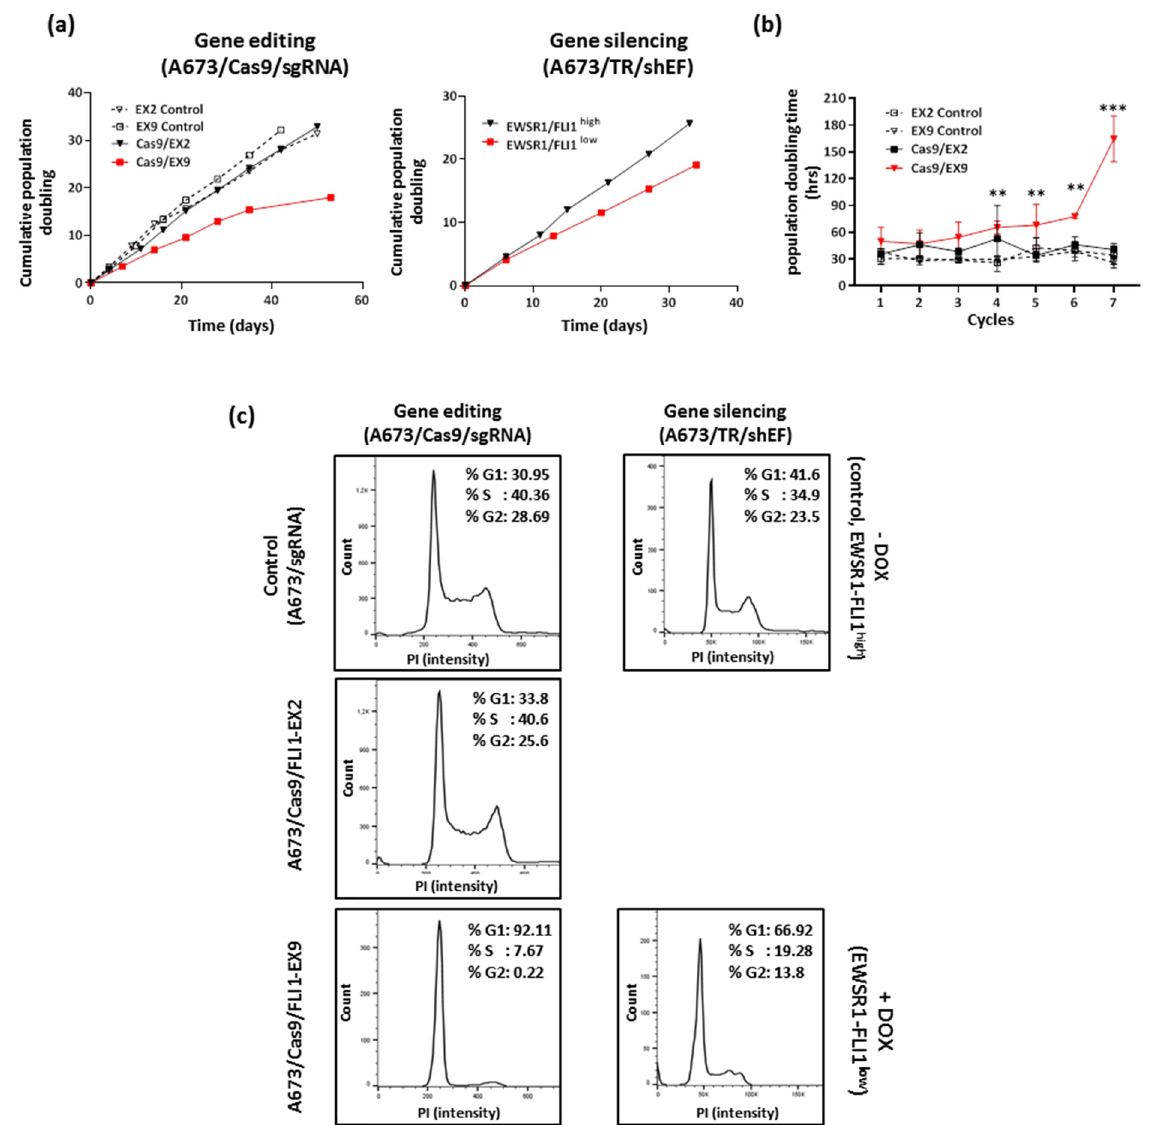
Figure 3. Effect of EWSR1–FLI1 gene editing on cell proliferation. ( a ) A673/Cas9/sgRNA cells were continuously main- tained in culture and the cumulative population doubling was recorded. The A673/TR/shEF cells were also continuously maintained in culture in the absence or presence of doxycycline (1 µg/mL). ( b ) Quantification of the population doubling time in each cycle of cell seeding–trypsinization. Mean ± SD of three independent experiments is shown (ns, not significant; ** p < 0.01, *** p < 0.001; two-way ANOVA Tukey’s post hoc vs. control). ( c ) The cell cycle was analyzed by flow cytometry in non-synchronized cells. The percentages of cells in each cell cycle phase are indicated. One representative experiment out of two independent experiments performed with similar results is shown.